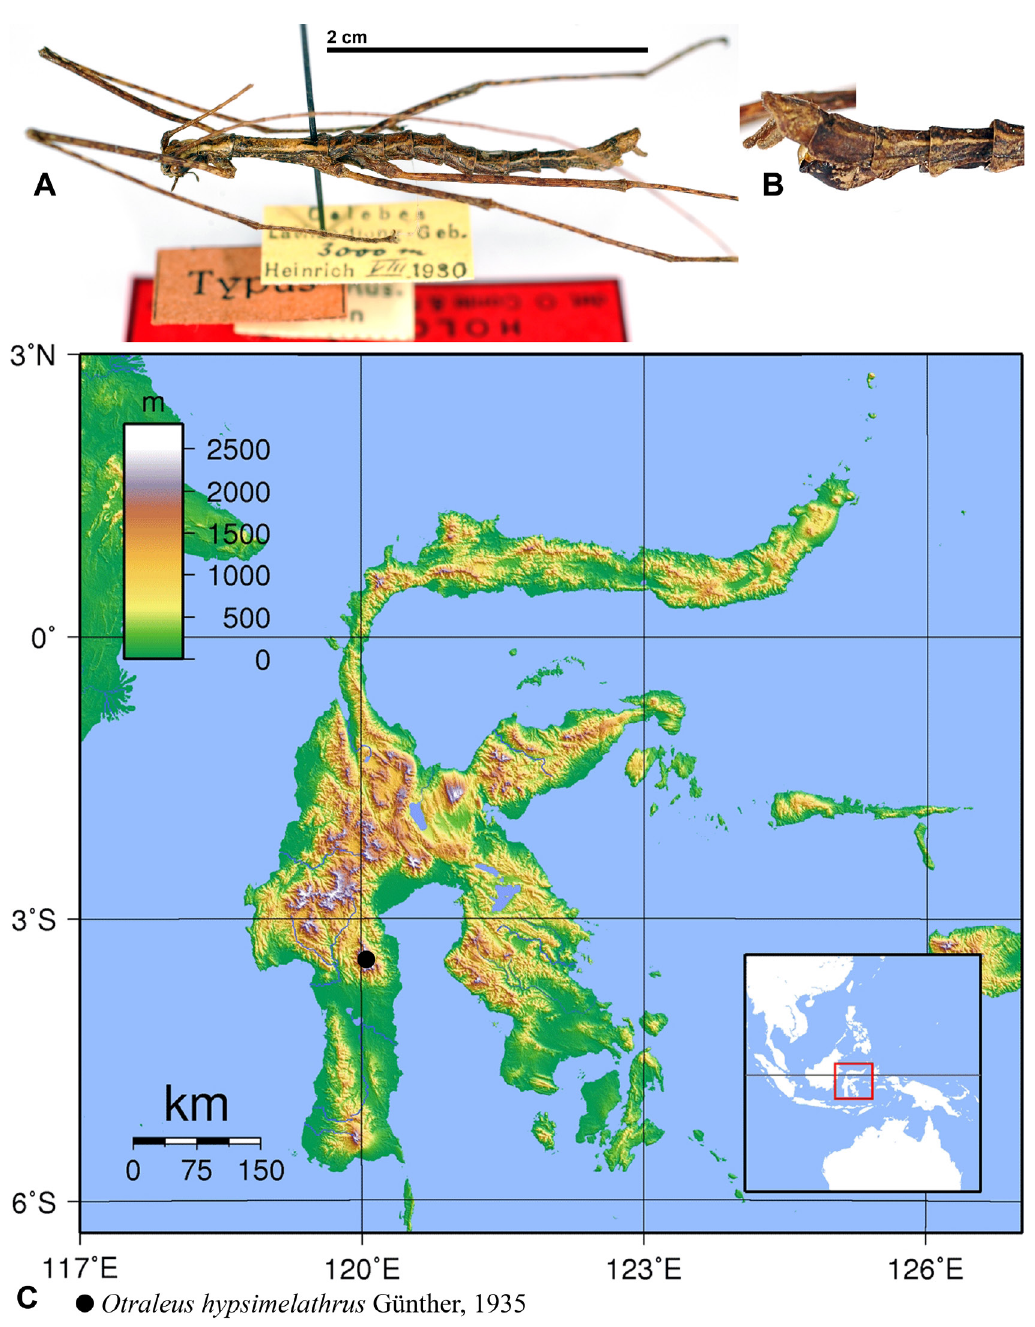
Fig. 1. Otraleus hypsimelathrus Günther, 1935, ♂, holotype (ZMHB). A . Habitus, lateral view. B . Apex of abdomen, lateral view. C . Distribution map in Sulawesi. (Photographs © O. Conle and F.